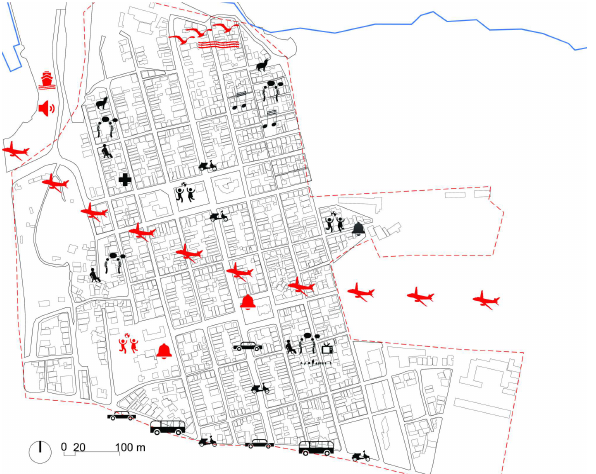
Figure 9: Sound signals and Sound marks map for Alikarnassos District Heraklion U.A., 2013.